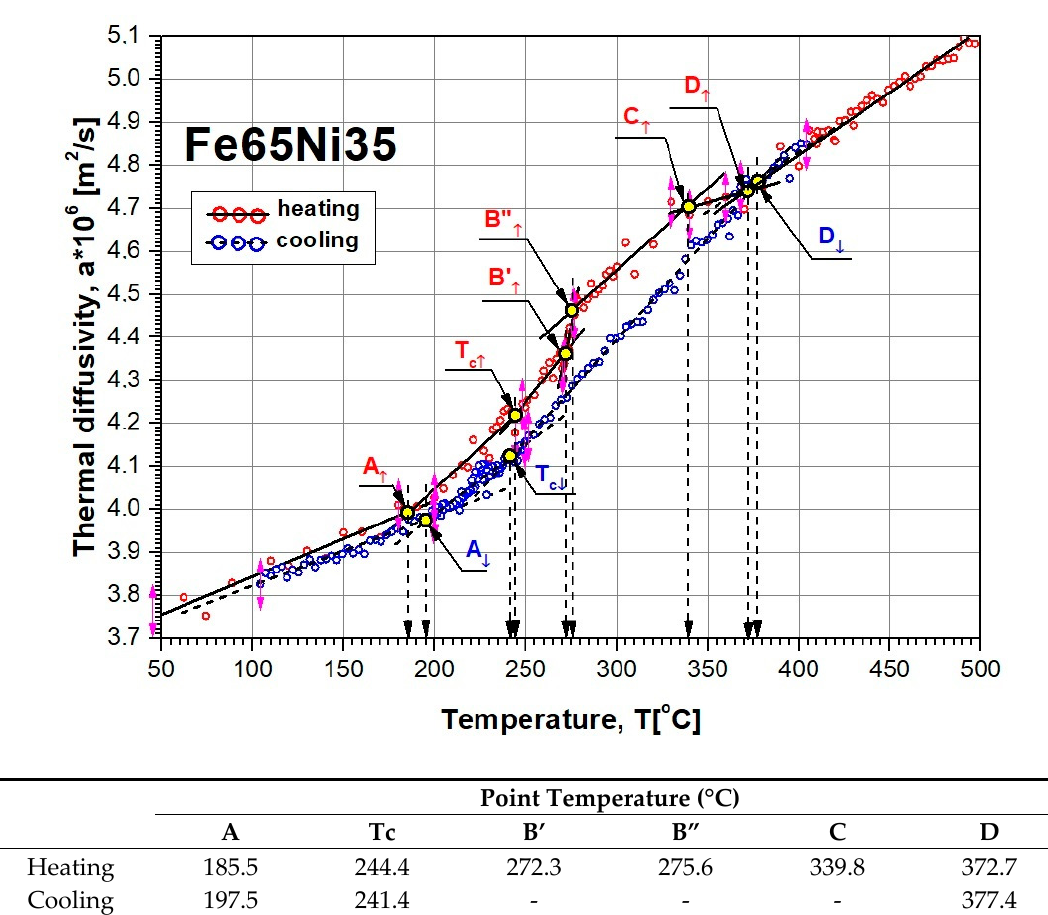
Figure 9. Temperature characteristics of thermal-diffusivity 𝑎(𝑇) changes of Fe65Ni35 adopted for further analysis together with estimated values of its characteristic points.